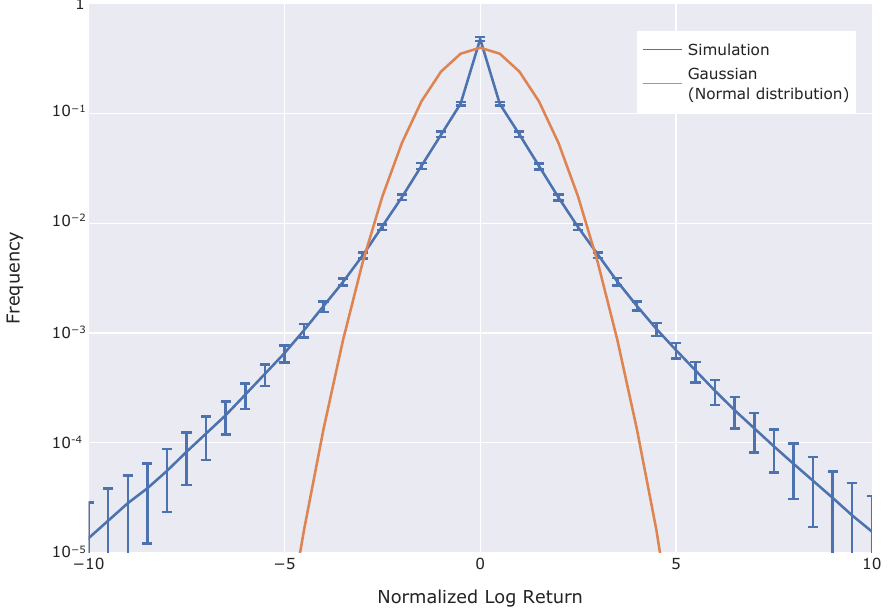
Figure 5. Frequency distribution of normalized log returns. The blue plot shows the results from simulations. Error bars mean standard deviation for each lag among 500 markets in 100 simulations. The orange plot shows the Gaussian (Normal)